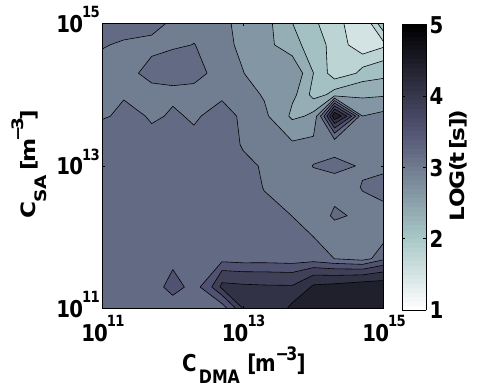
Fig. 2. The maximum length of simulation time required to con- verge the individual concentrations in the dimethylamine/sulfuric acid simulations, shown as a function of the monomer concentra- tions. The colour scale is shown on the right, and gives the base-10 logarithm of the time required for convergence (in seconds) as de- fined in the text.